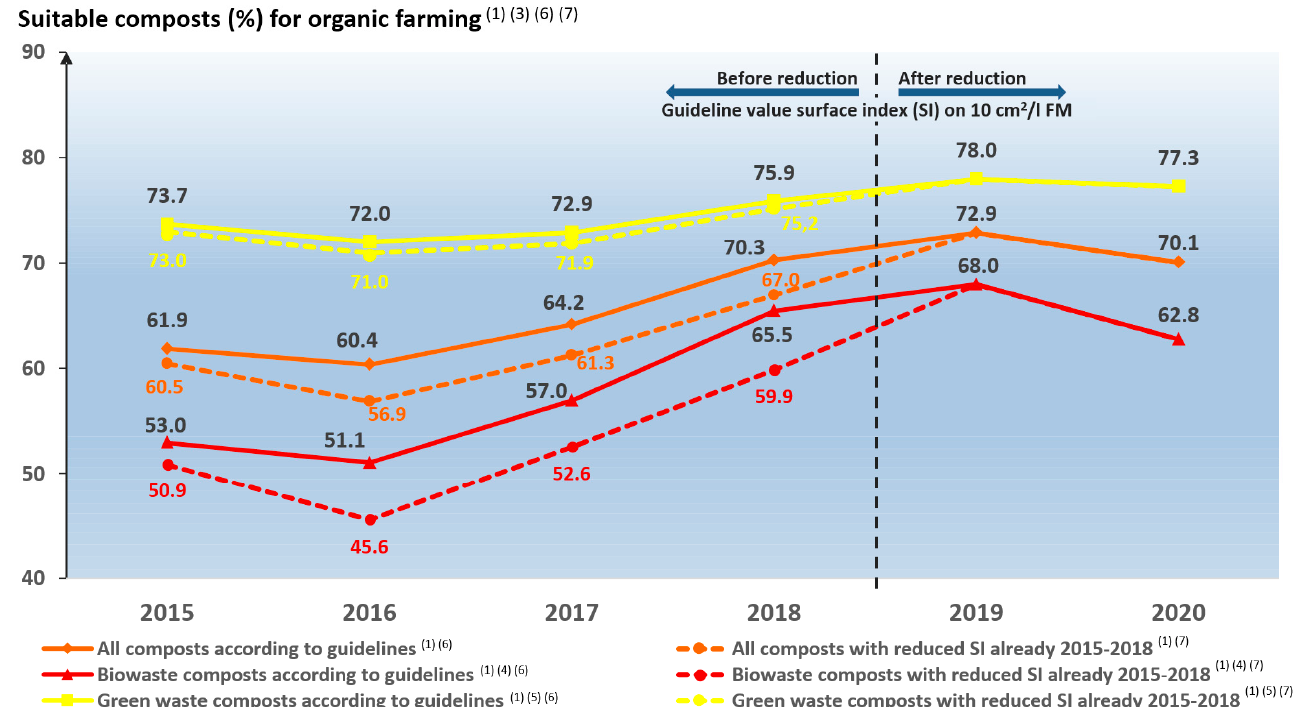
Figure 3. Proportion of biowaste and green waste composts suitable for organic farming in Germany in 2015 to 2020 (composts according to RAL-GZ 251 Compost from BGK 2015–2020) (1).(2) . (1) Limit values ( ≤ ) according to EU-ÖkoV—EU Organic Farming Regulation (VO (EC) 889/2008, Annex 1 resp. 2021/1165, Annex 2) and guideline values ( ≤ ) according to Bioland/Naturland guidelines (5/2014 to 3/2020). (2) n = 3272 in 2015, n = 3345 in 2016, n = 3361 in 2017, n = 3536 in 2018, n = 3677 in 2019, n = 3841 in 2020, data from RAL Quality Assurance 251 (BGK, 2016–2021). (3) % of all analyzed composts according to RAL-GZ 251 Compost. (4) Biowaste composts (with and without upstream anaerobic digestion). (5) Green waste composts. (6) Incl. foreign matter (also parameter surface index (SI)). Foreign matter is not regulated according to EU-ÖkoV but to Bioland/Naturland guidelines. Composts according to Bioland/Naturland guidelines are regulated with guideline surface index (SI) ≤ 15 cm 2 /l FM from 2015 to 2018, ≤ 10 cm 2 /l FM from 2019 onwards. (7) Composts with theoretical approach of a reduced guideline value for surface index (SI) ≤ 10 cm 2 /l FM also already from 2015 to 2018 (mandatory only from 2019 onwards)–s. (6) ).